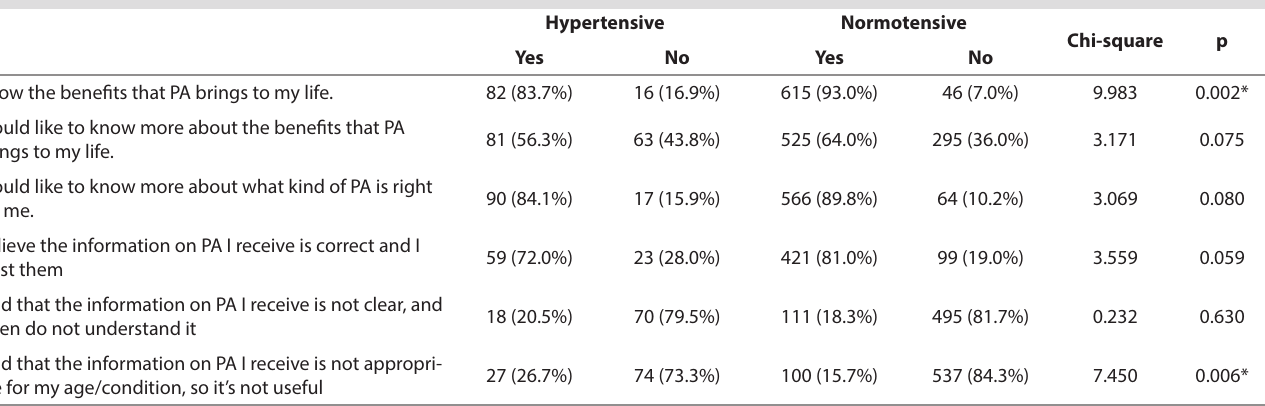
TABLE 4. Perceived knowledge about physical